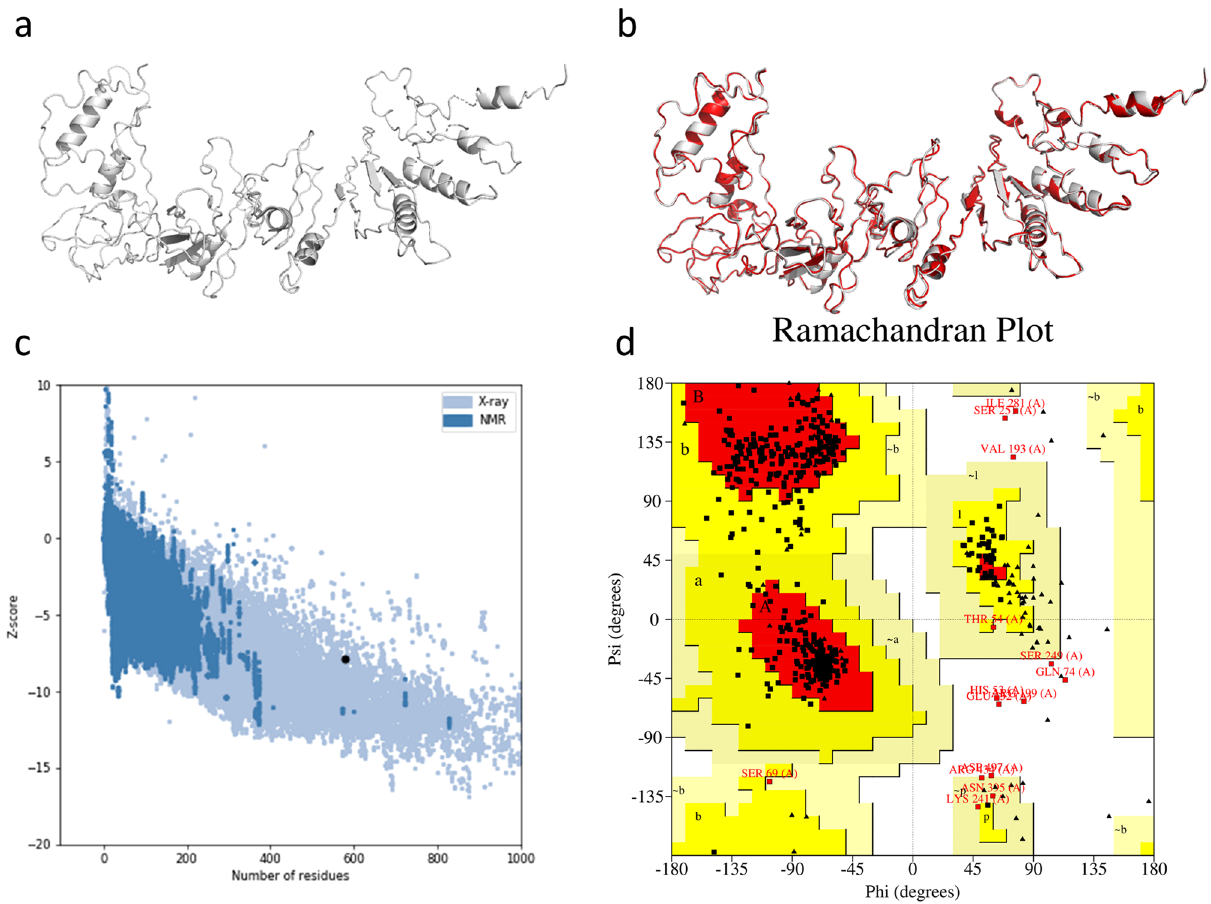
Figure 6. Vaccine 3D modelling, refinement, and assessment. ( a ) The 3D model produced by RaptorX (gray). ( b ) The refined 3D model with GalaxyRefine (red) overlapped with the original RaptorX 3D model (gray). ( c ) The Z-score (-7.9) obtained with ProSa-Web. ( d ) The Procheck Ramachadran plot showing 80.8% of the residues in favoured regions, 17.3% in allowed regions, and 2% in disallowed regions.